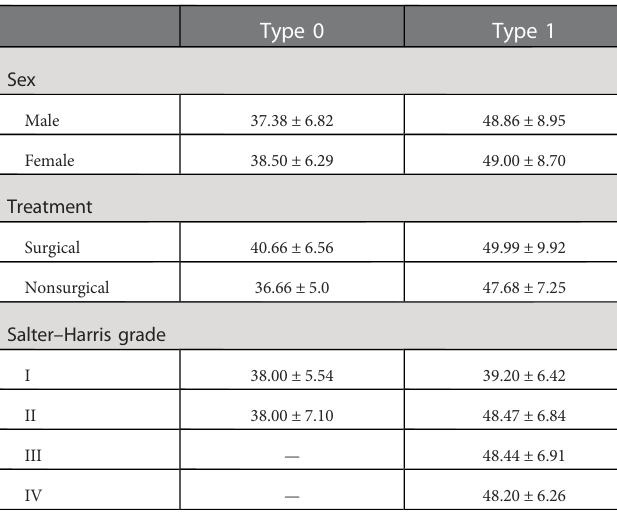
TABLE 5 Time to appearance of growth arrest line in normal healing